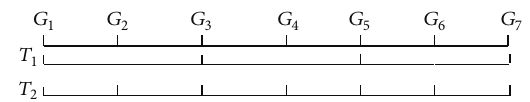
Figure 1: Stop schedule plan of the intercity passenger rail